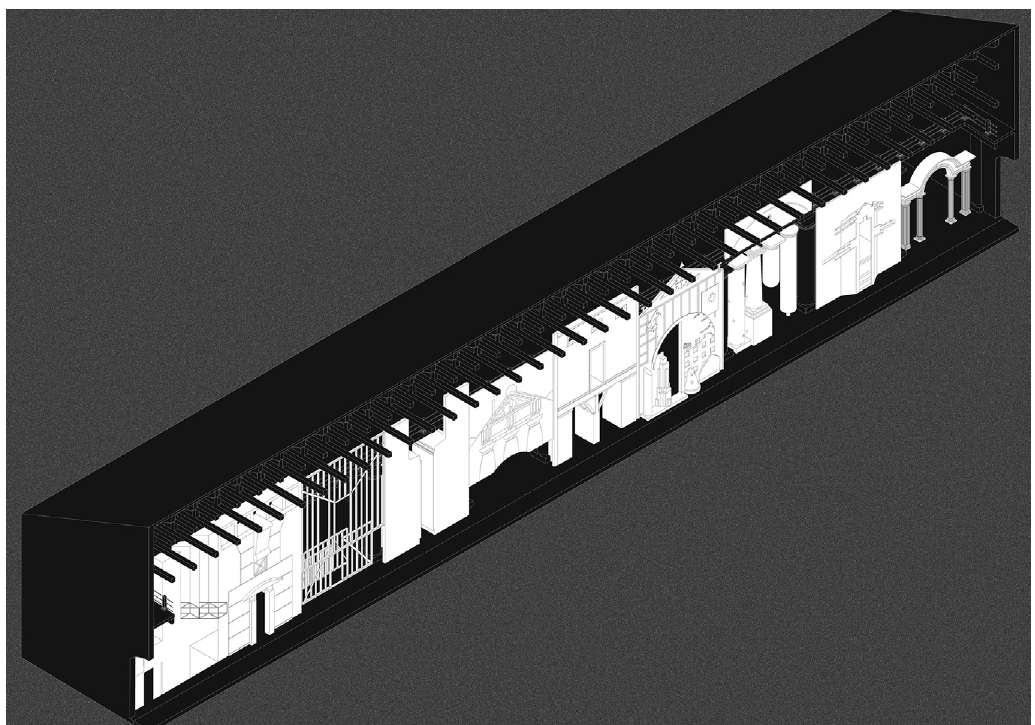
Figure 2. Some facades of “Strada Novissima” set up at the Corderie dell’Arsenale in 1980. Authors, left to right: Costantino Dardi; Michael Graves; Frank O. Gehry; Oswald Mathias Ungers; Robert Venturi, John Rauch and Denise Scott-Brown; Léon Krier; Joseph-Paul Kleihues; Hans Hollein; Massimo Scolari; Allan